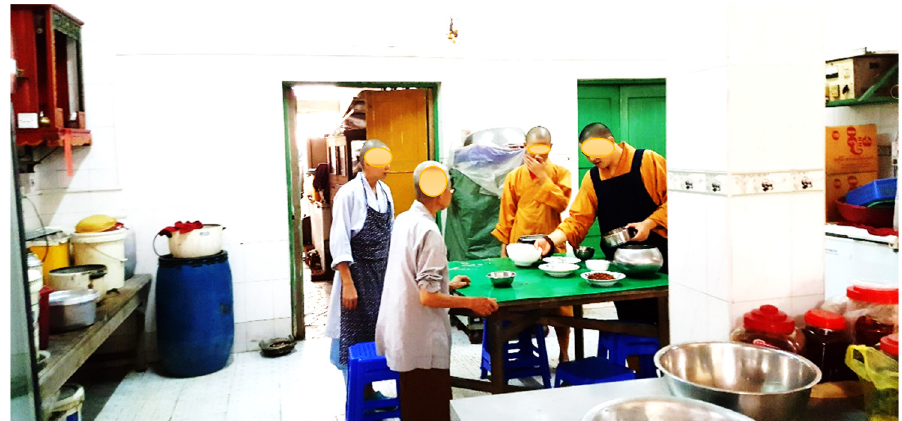
Figure 7. Two bhik ṣ u ṇ ī s working in a kitchen, cooking for male monastics (Source: